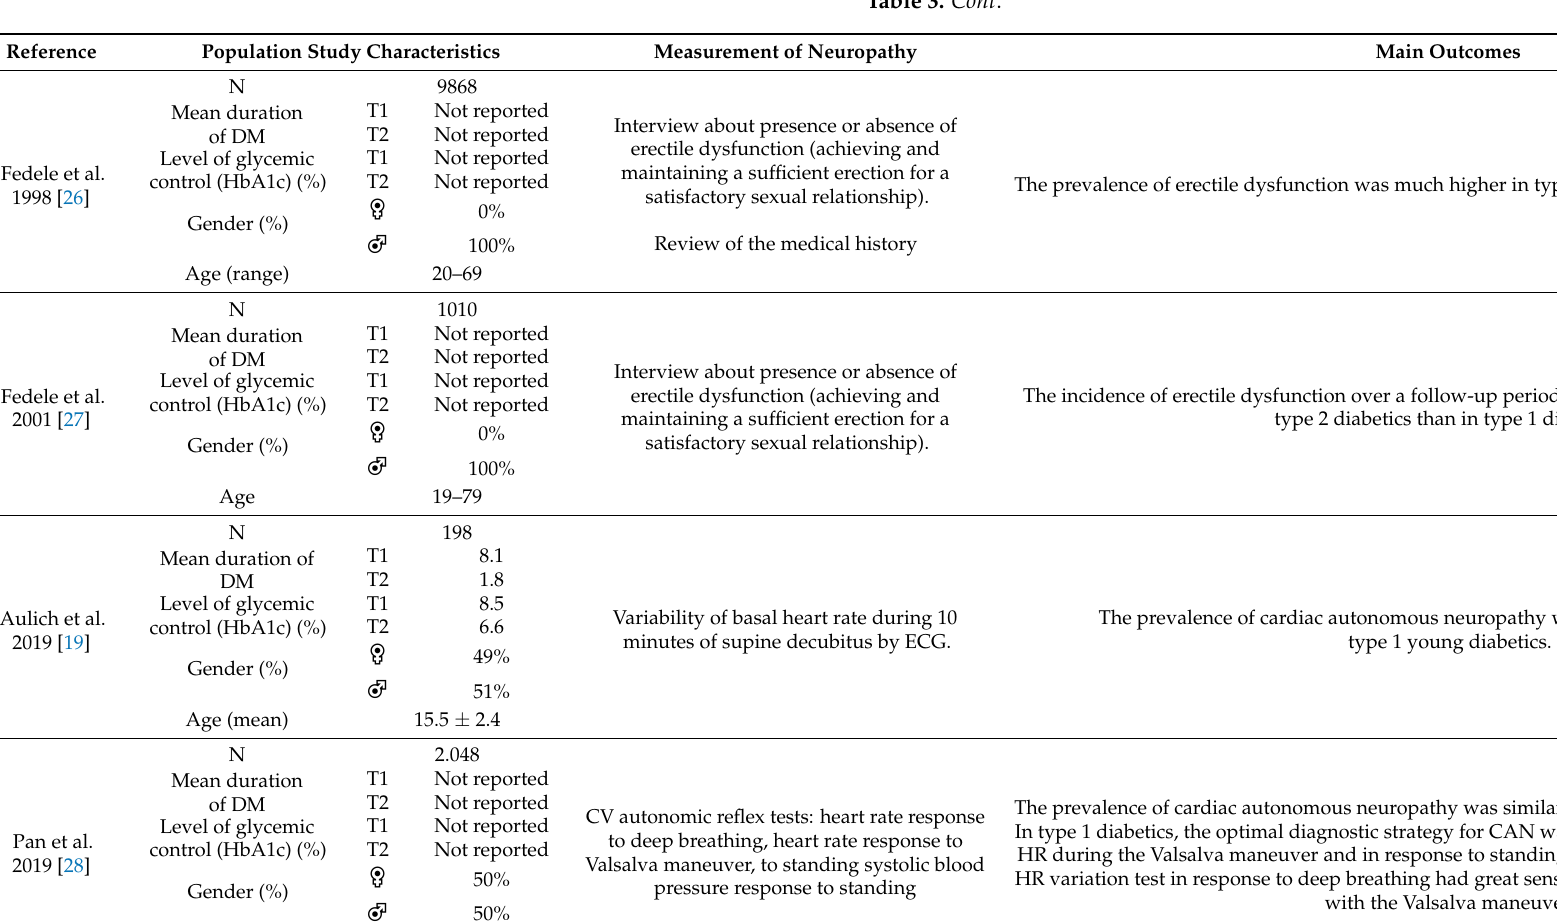
Table 1. Differences between type 1 (T1) and type 2 (T2) diabetes in sensory neuropathy. Figure 1. Systematic review workflow.